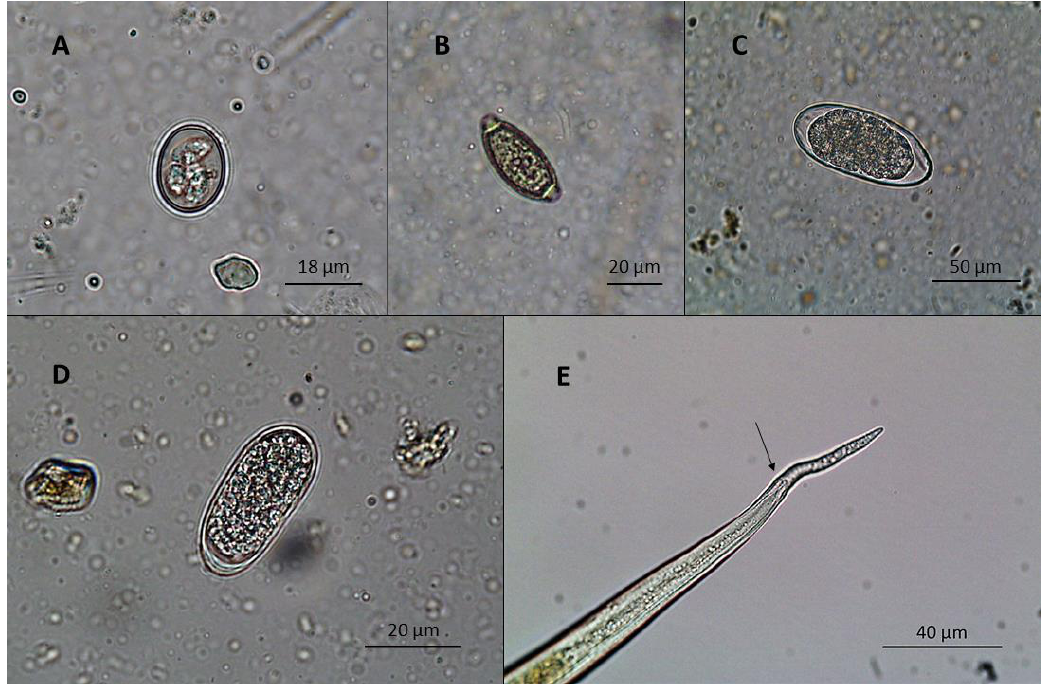
Figure 3. ( A ) Eimeria sp. oocyst; ( B ) Capillaria sp. egg; ( C ) T. tenuis egg; ( D ) S. pavonis egg; ( E ) tail and sheath end of L. douglassii L3 identified in emus, highlighting the typical tail-end knob format (black arrow) (originals).